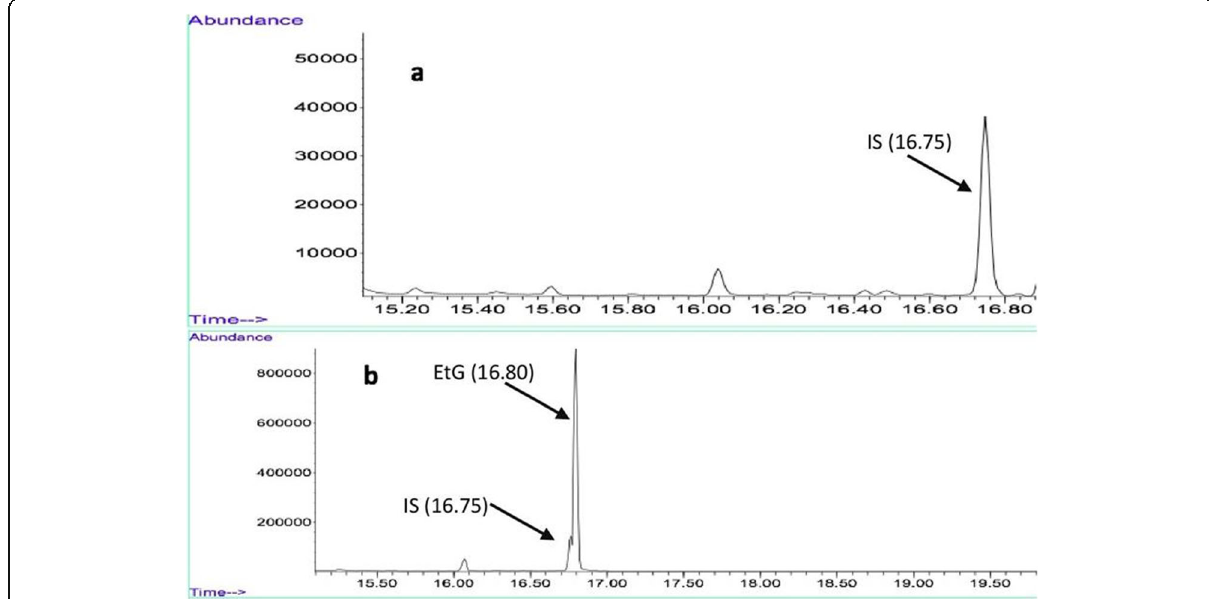
Fig. 1 a Chromatogram of blank urine with IS (500 ng/ml). b Chromatogram of urine spiked with EtG (5000 ng/ml) and IS